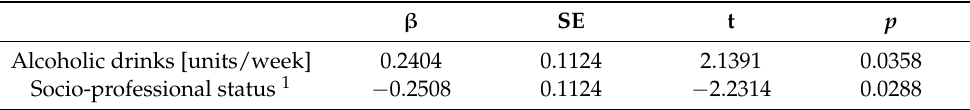
Table 9. Multivariate linear regression analysis assessing the relationship between total physical activity [MET—min/day] measured by IPAQ and selected variables in the total study population ( n = 75).